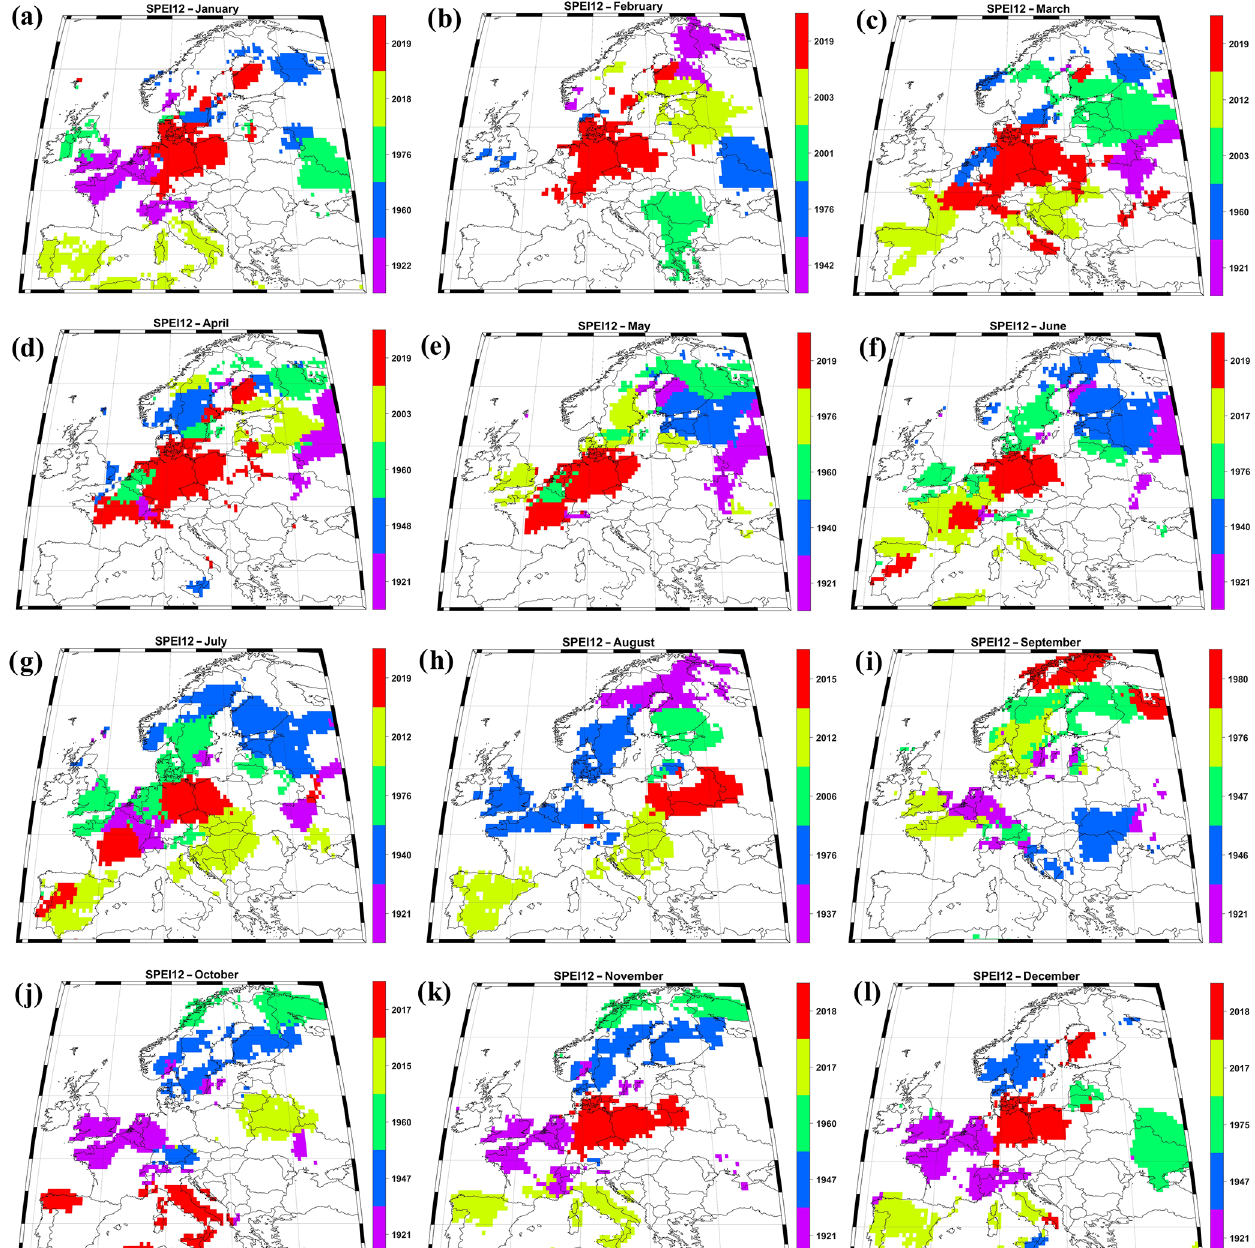
Figure 9. The spatial extent and date of the driest years based on the monthly SPEI12 over Europe. Analyzed period: